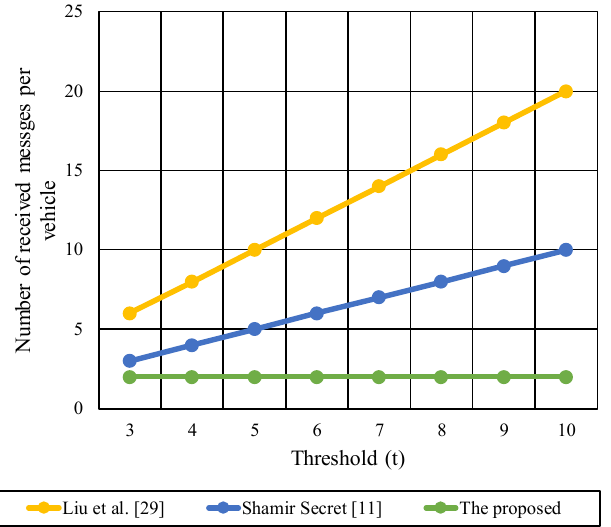
Figure 9. The received messages per participant vehicle during the key reconstruction phase.